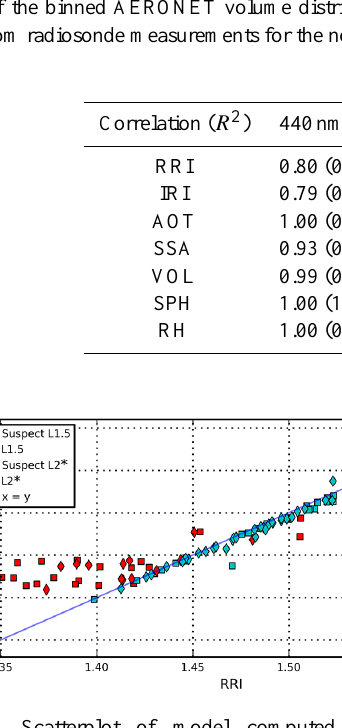
Figure 5. Scatterplot of model computed (optimized) and AERONET total volume (level 1.5: squares, L2*: diamonds). AERONET data that have been classified as suspect have been marked in red. The blue line shows the 1 : 1